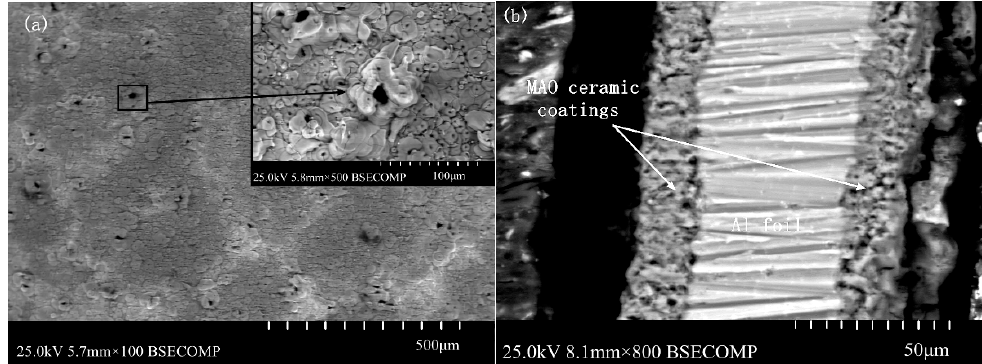
Figure 3. The surface morphology and cross section of the MAO ceramic coatings: ( a ) surface morphology and ( b ) cross section.